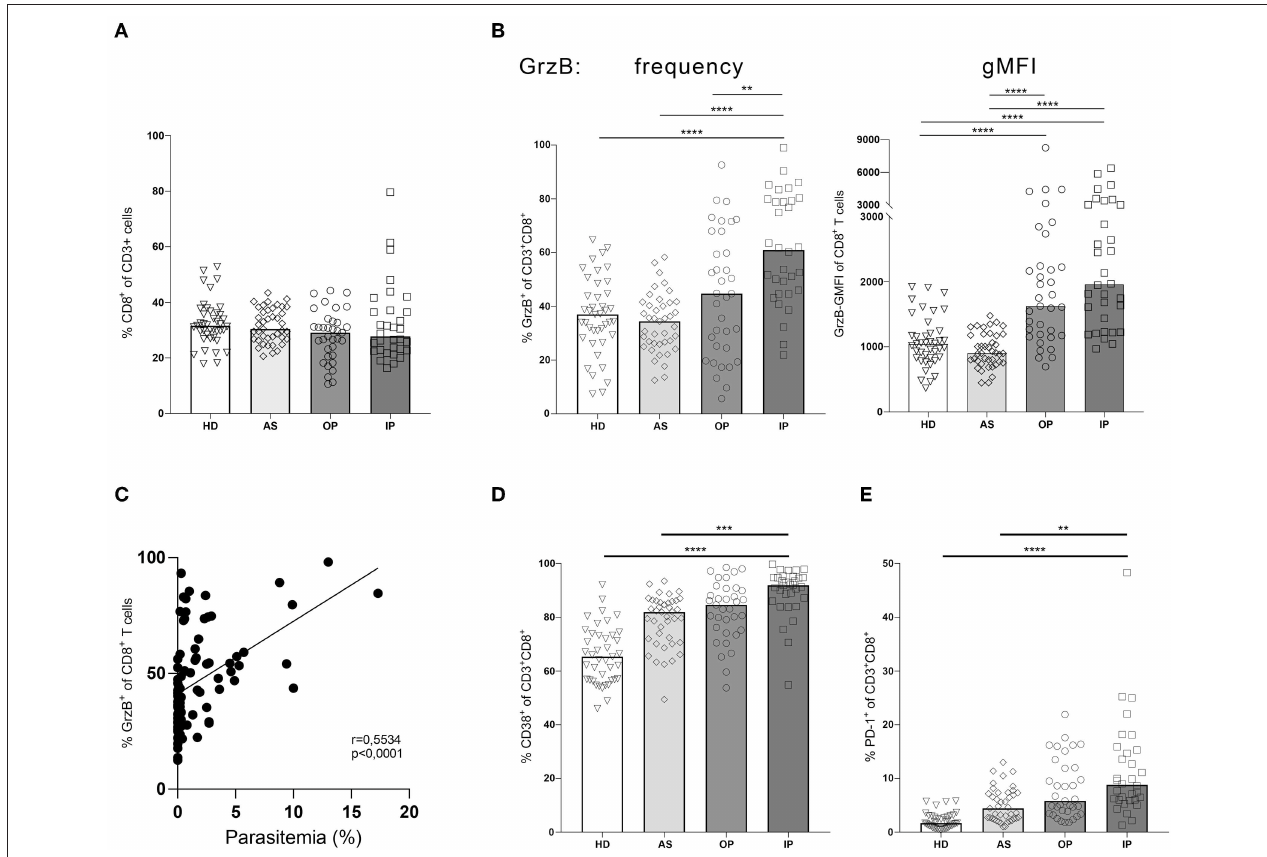
FIGURE 3 | Granzyme B expression in CD8 + T cells correlates with disease progression. Blood samples from children infected with P. falciparum but lacking symptoms (AS, n = 41), children treated as outpatients for uncomplicated malaria (OP, n = 35), children treated as inpatients for severe malaria (IP, n = 32), as well healthy, non-infected children (HD, n = 41) were stained with fluorescent labeled α CD3, α CD8, α CD4, α Granzyme B, α CD38, and α PD-1 antibodies for flow cytometric analyses. (A) Frequencies of CD8 + T cells among CD3 + cells were assessed in all 4 groups. (B) The CD8 + CD3 + T cells were further analyzed for the expression of the effector molecule granzyme B, (D) CD38 and (E) PD-1 in all four groups. Statistical significance was determined using Kruskal–Wallis Test with post-hoc Dunn’s test: **** p < 0.0001; *** p < 0.001; ** p < 0.01; * p < 0.05. (C) The correlation between the frequency of GrzB expression by CD3 + CD8 + T cells and parasitemia was analyzed in the blood of all infected children ( n = 89), using Spearman rank